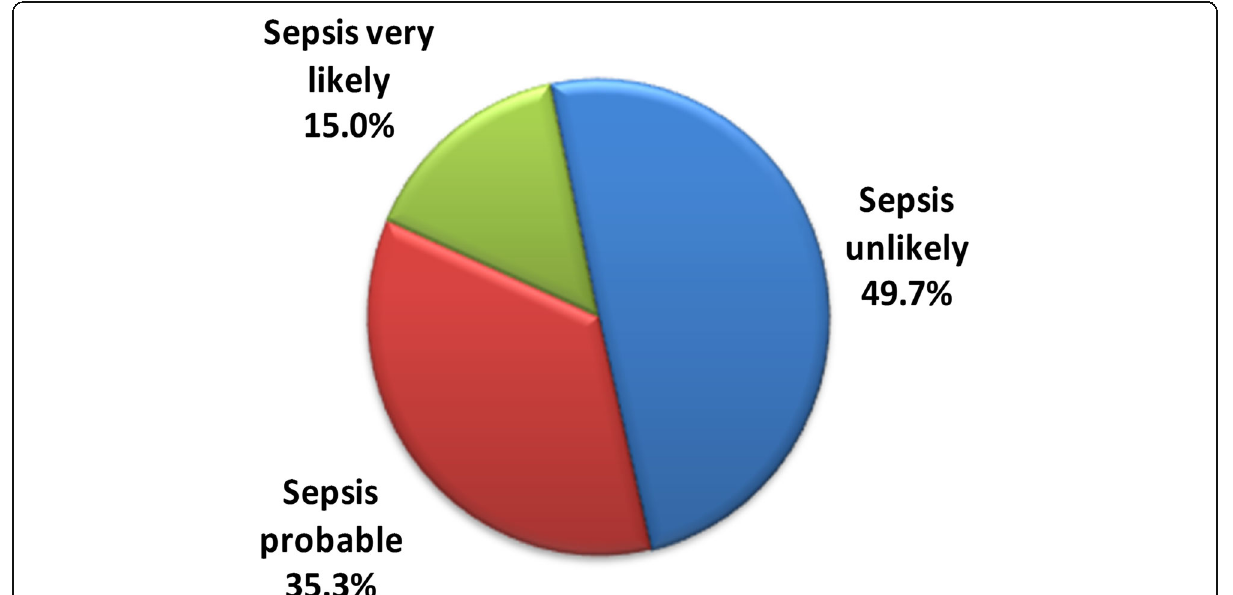
Fig. 2 Classification of septic newborn babies using hematological scoring